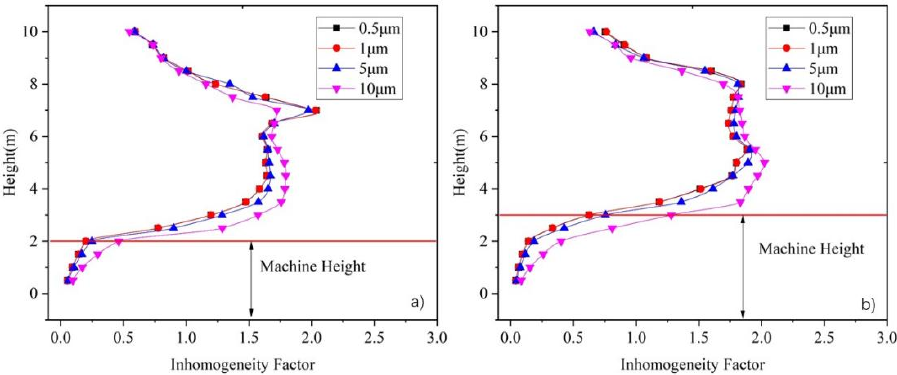
Figure 17. Inhomogeneity factor distribution for difference machine heights under ACR = 6. ( a ) Ma- chine height of 2 m, and ( b ) machine height of 3 m. ( a ) Machine height of 2 m, and ( b ) machine height of 3 m.